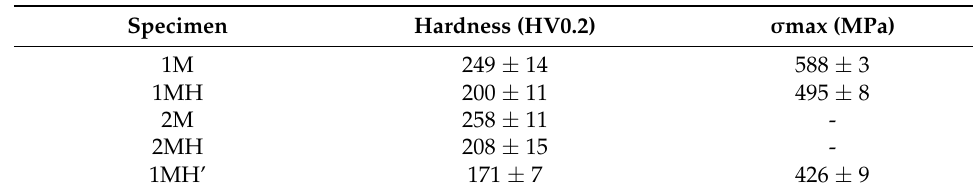
Table 10. Microhardness and maximum compressive strength average values of the manufactured alloy in as-cast and heat-treated conditions.